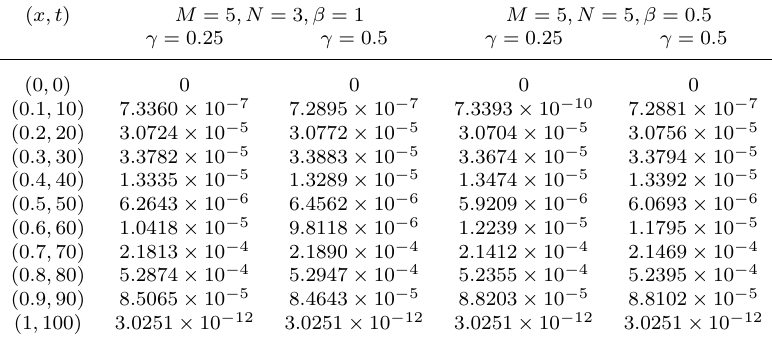
Table 5. Absolute errors for different values of M,N,β,γ on the interval [0 , 1] × [0 , 100] for Example 5. ( x,t ) M = 5 ,N = 3 ,β = 1 M = 5 ,N = 5 ,β = 0 . 5 γ = 0 . 25